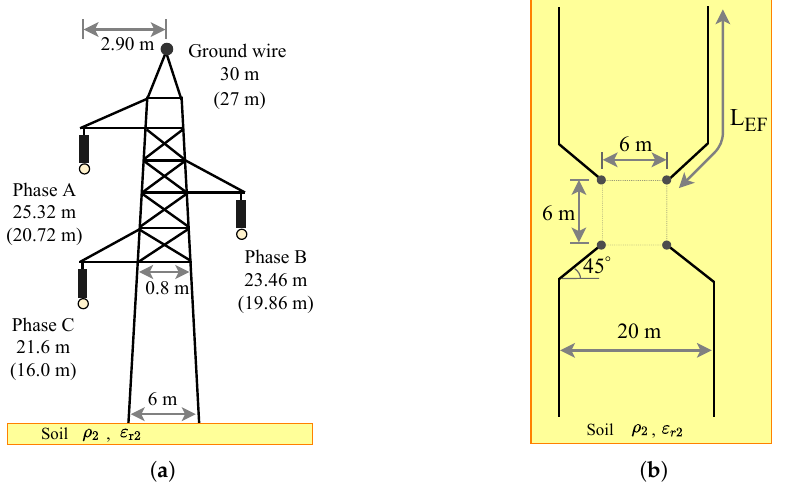
Figure 3. ( a ) Tower silhouette and; ( b ) Arrangement of tower-footing grounding